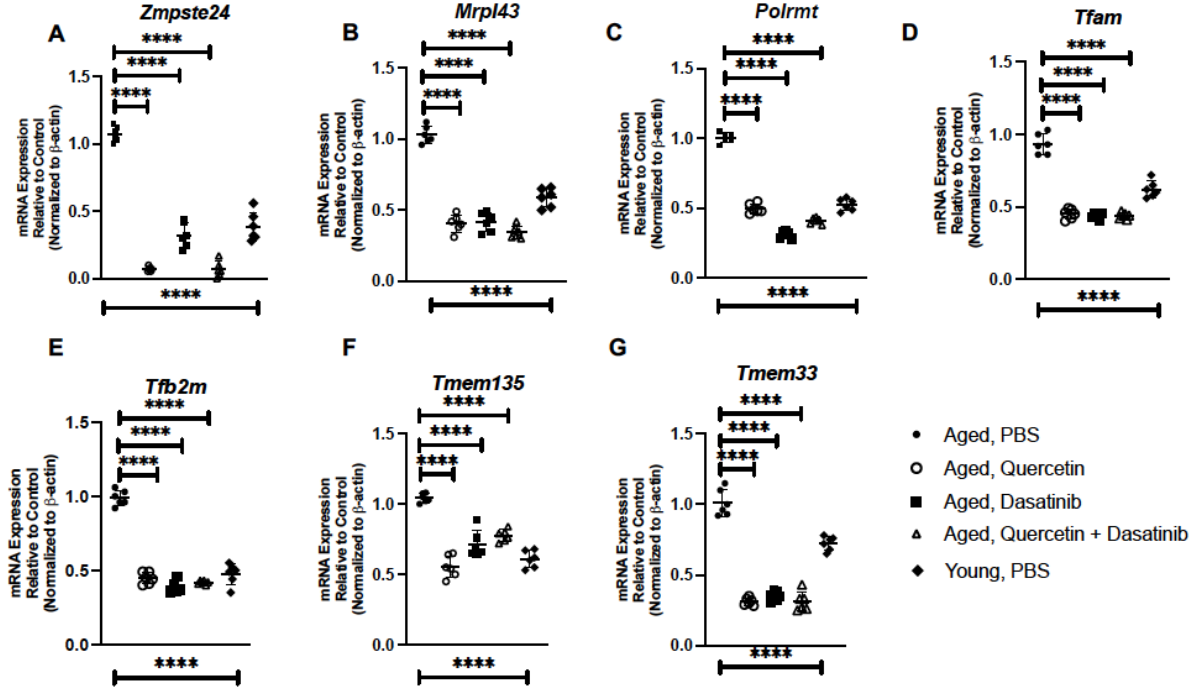
Figure 3. Treatment of Aged Mice with Senolytics Alters Senescence Gene Expression in Aged Lung. Lung tissue was collected from PBS-, quercetin-, dasatinib-, and quercetin + dasatinib-treated aged adult BALB/c mice (20 months of age). Expressions of ( A ) Zmpste24 , ( B ) Mrpl43 , ( C ) Polrmt , ( D ) Tfam , ( E ) Tfb2m , ( F ) Tmem135 , and ( G ) Tmem33 were assessed by real-time PCR. N = 6 mice per group, and the experiment was repeated 3 times. Young (3 months) PBS-treated lung expression analysis is included for comparison **** p < 0.0001.